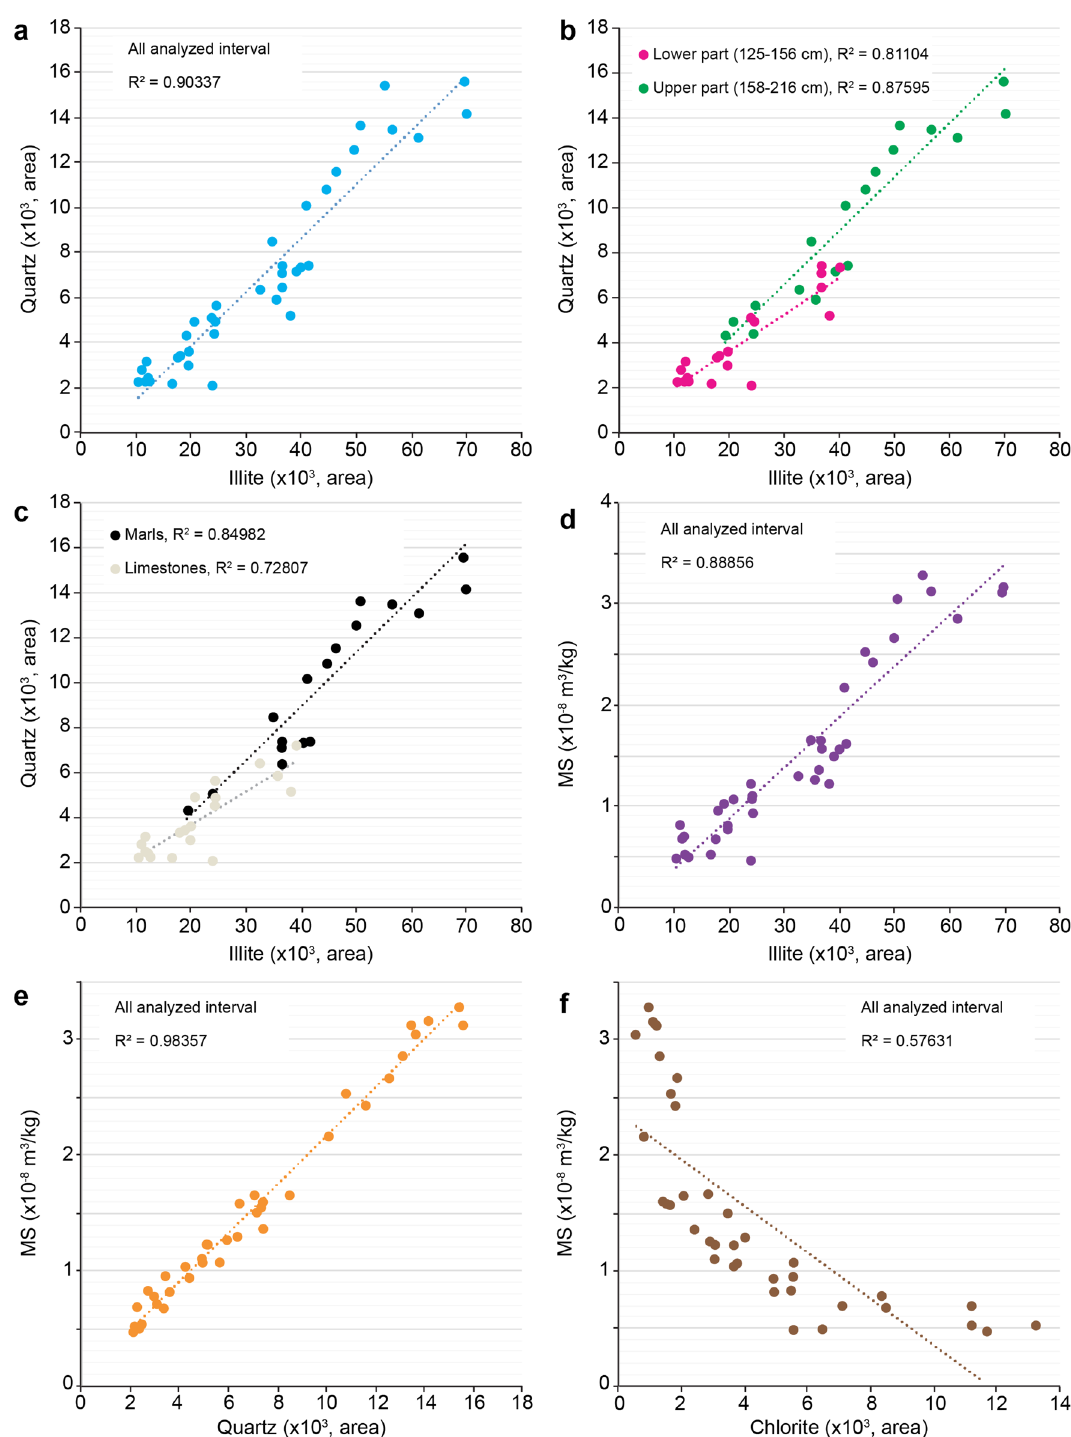
Figure 7. Cross-plots of the multiple studied proxies. Measured values for minerals (clay minerals and quartz) correspond to the main diffraction peak areas (a) Illite–Quartz correlation. (b) Illite–Quartz correlation over two distinct intervals, 125–156 cm (showing significant variations of chlorite content) and 158–216 cm (showing weak variations of chlorite content). (c) Illite–Quartz correlation over the two main lithologies, only limestones (white points) and only marls (black points). (d) Illite–magnetic susceptibility (MS) correlation. (e) Quartz–MS correlation. (f) Chlorite–MS